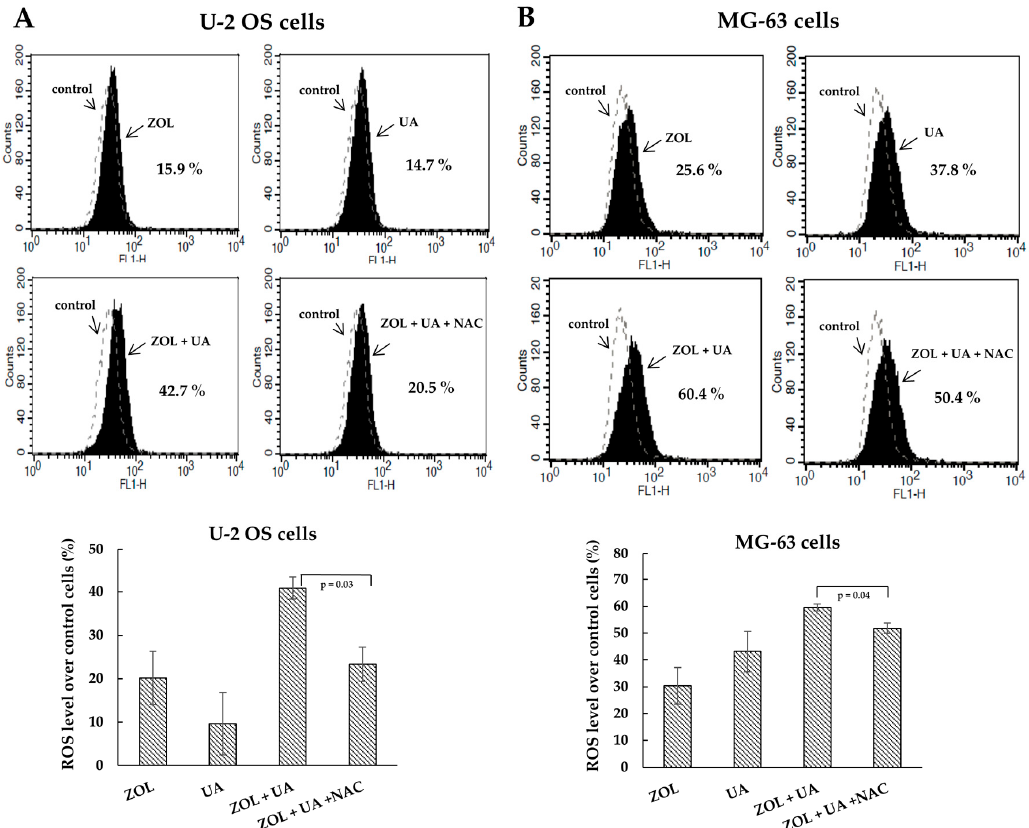
Figure 6. Zoledronic acid combines with ursolic acid to enhance reactive oxygen species (ROS) generation. U-2 OS cells ( A ) or MG-63 cells; ( B ) were treated with either ZOL (10 μ M), UA (20 μ M) or a combination of ZOL/UA in the absence or presence of N -acetyl- L -cysteine (NAC) (2 μ M) for 16 h. The cells were stained with hydroethidine (10 μ M) and ROS levels were analyzed by flow cytometry. Numbers indicated the induced levels of ROS in drug-treated cells compared to control cells. The results were calculated by a median of fluorescence intensity in each group.